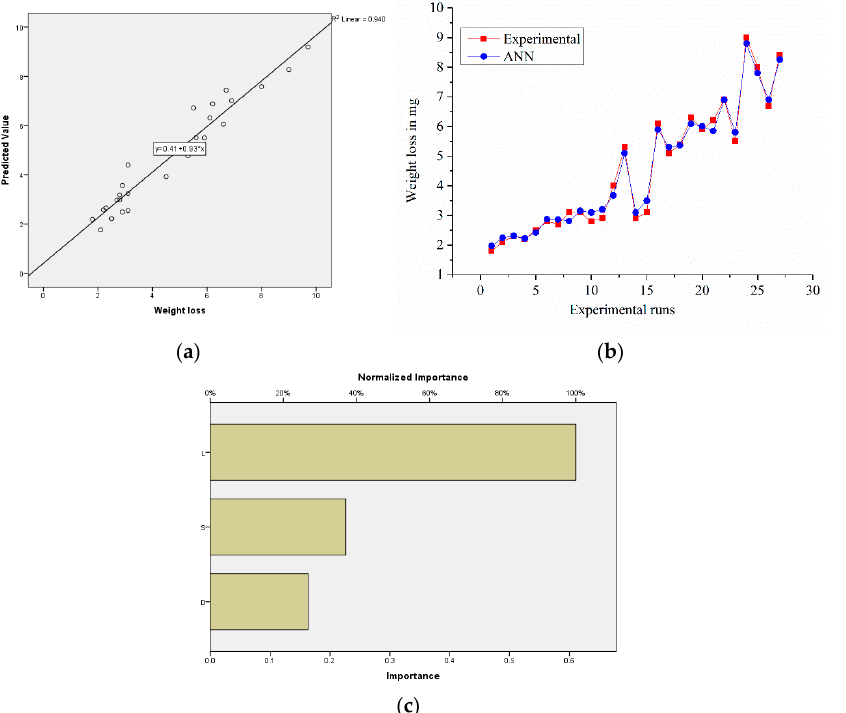
Figure 15. ( a ) Experimental vs. predicted values of the samples; ( b ) error-values; ( c ) normalized factor importance.